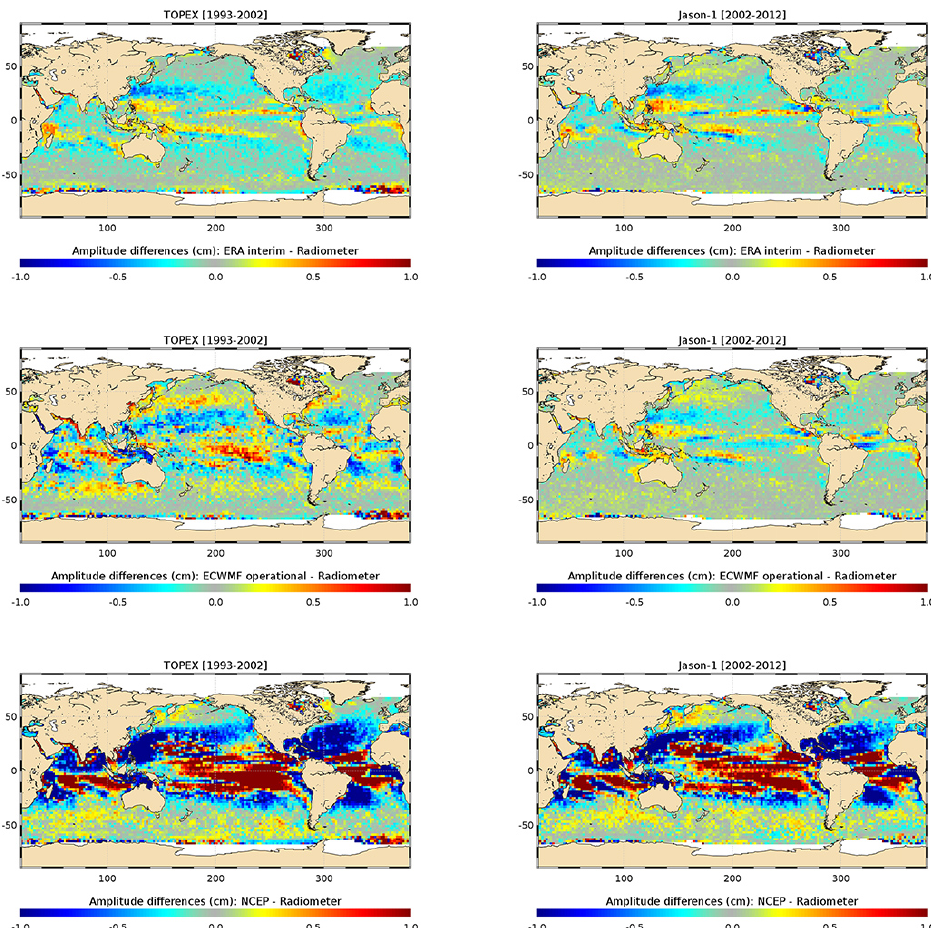
Figure 7. Regional differences in the annual signal’s amplitude of the wet troposphere corrections (in cm) comparing each model (top: ERA-Interim; middle: operational ECMWF; bottom: NCEP/NCAR) with the radiometers over the first (left, TP data) and the second (right, Jason-1 data) altimetry decade. Contrary to other figures, we compare here the annual signal of the WTC